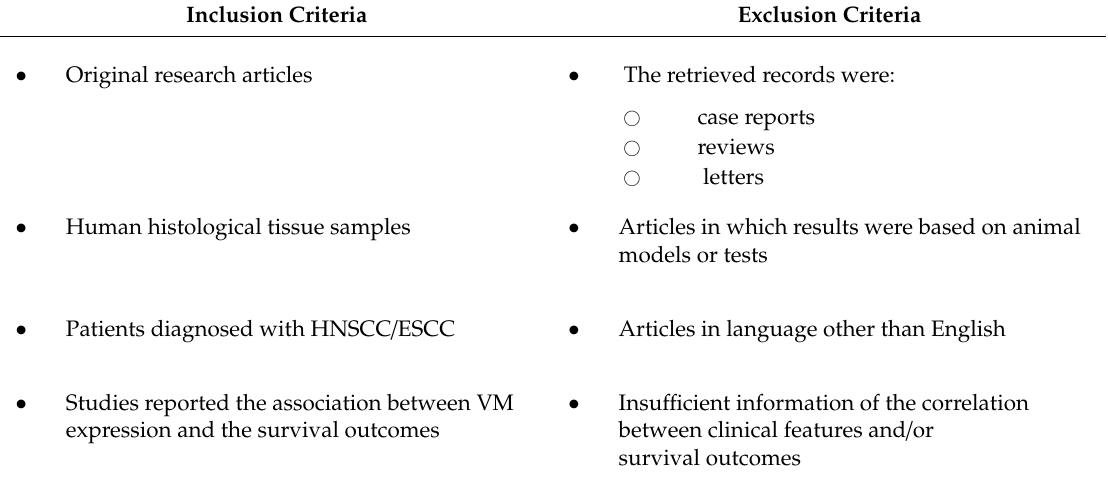
Table 1. Inclusion and exclusion criteria applied in this